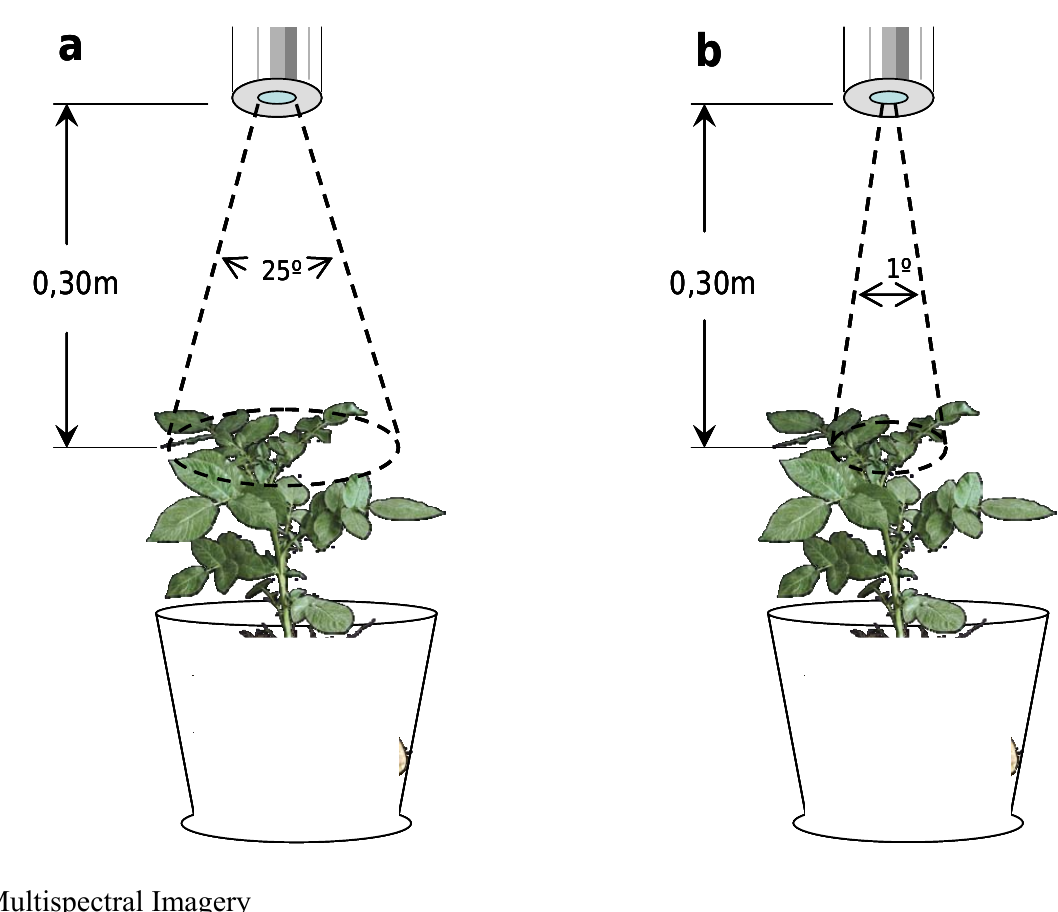
Figure 1. Aperture of the spectroradiometer sensor for each experiment. ( a ) Experiment with a 25° solid angle aperture, ( b ) Experiment with a 1° solid angle